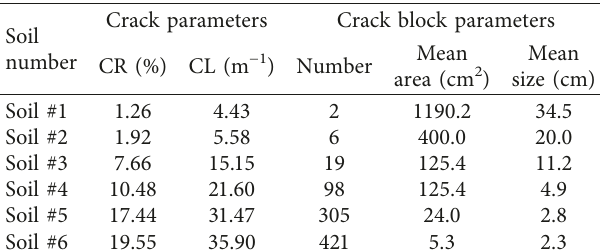
Figure 2: Shrinkage cracking test results of the six types of CCLs. (a) Soil #1. (b) Soil #2. (c) Soil #3. (d) Soil #4. (e) Soil #5. (f) Soil #6. Table 3: Cracking characteristic parameters of the six